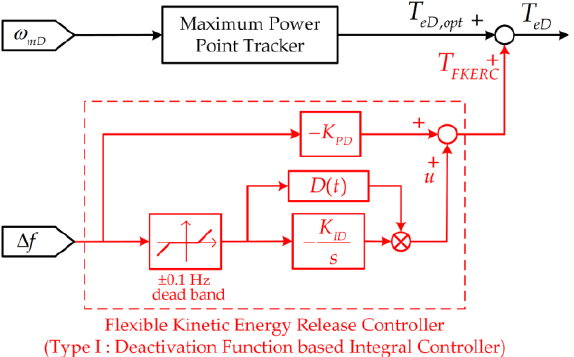
Figure 3. Deactivation function based integral controller.